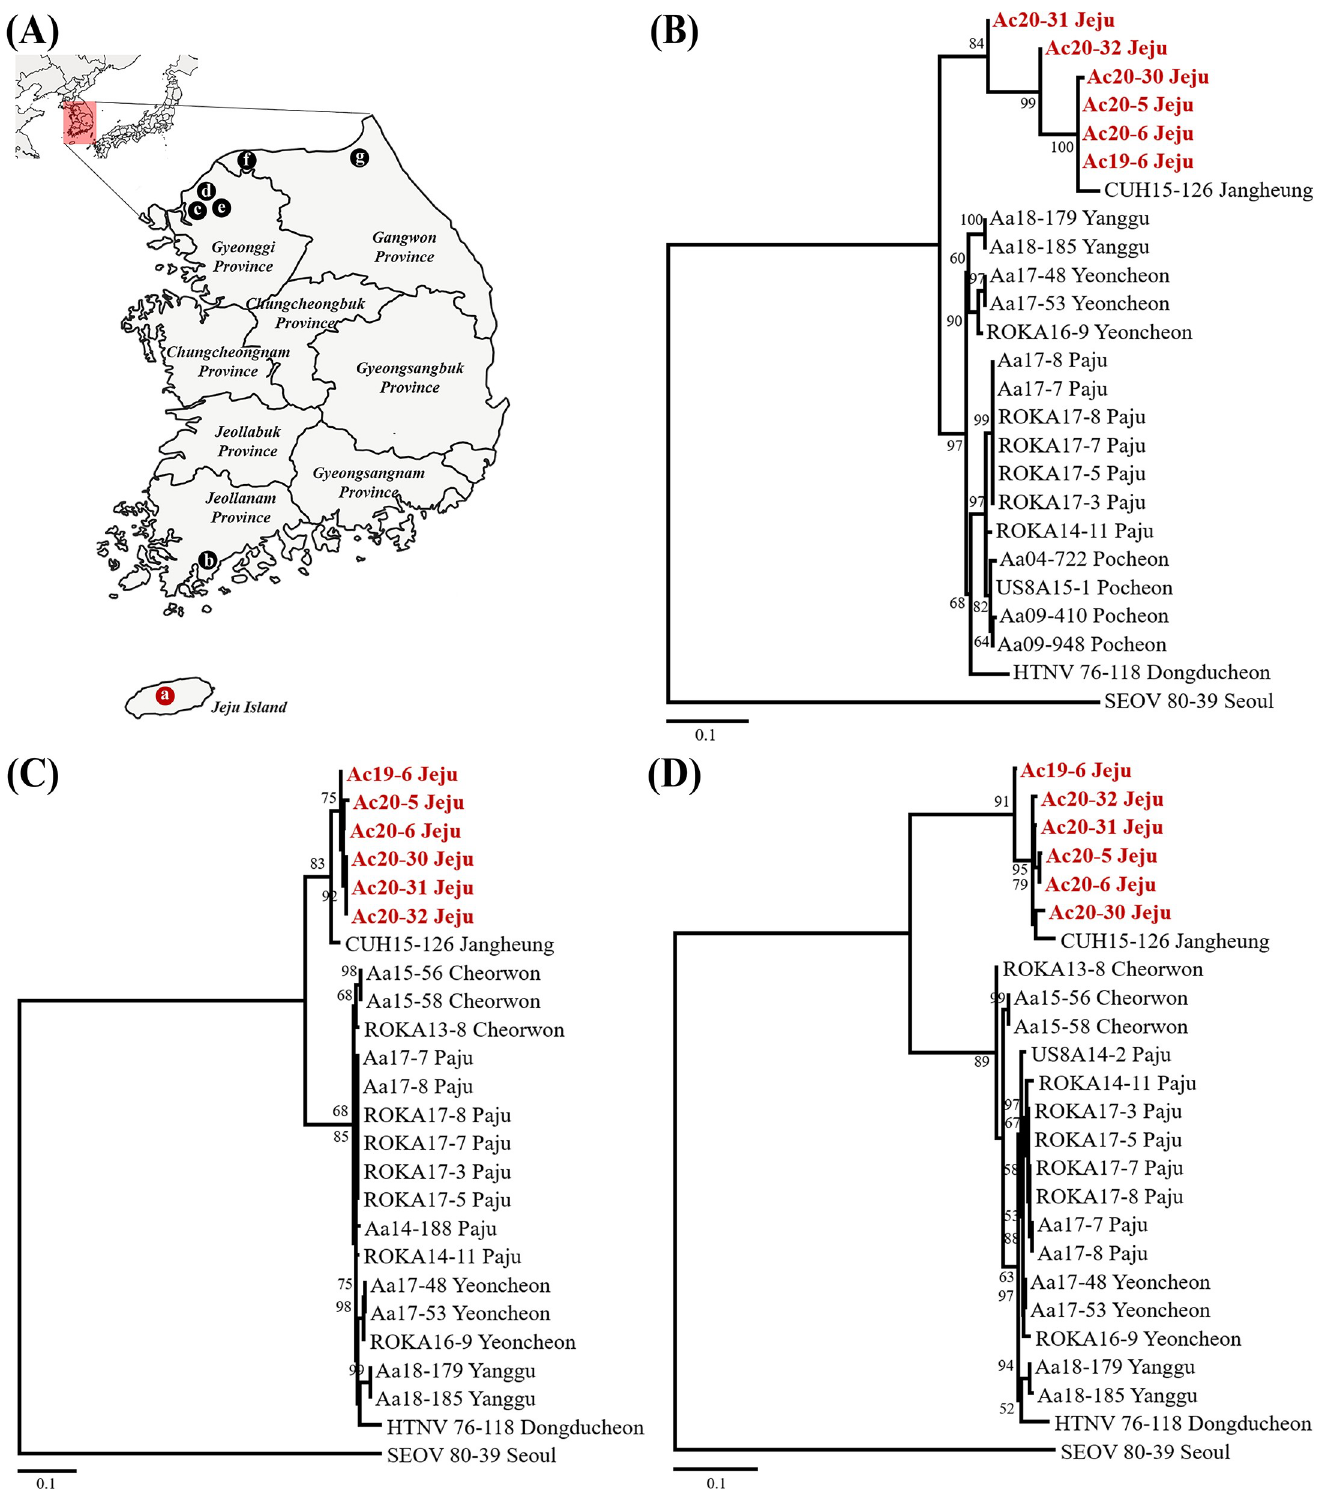
Fig 4. Phylogeographic analysis of the L, M, and S segments of Hantaan virus (HTNV) collected from rodents and patients with hemorrhagic fever with renal syndrome (HFRS) in Republic of Korea (ROK). (A) Geographic locations (circle symbols) indicate where the HTNV genomes were acquired in mainland and Jeju Island, ROK. The circle indicates geographic sites (a, Jeju; b, Jangheung; c, Paju; d, Yeoncheon; e, Pocheon; f, Cheorwon; g, Yanggu). Phylogenesis were generated by maximum-likelihood based on the alignment (Clustal W method) using the (B) 353-nucleotide L (coordinates 2,963–3,315 nt), (C) 369-nucleotide M (coordinates